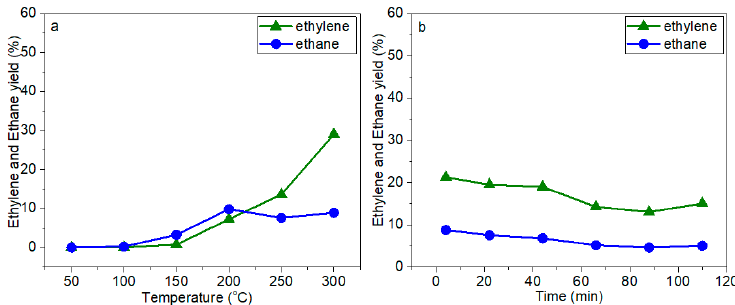
Figure 12. Catalytic HDCl of TCE on ZrO 2 supported mixed-shape (m) Pd NPs: ( a ) ethylene and ethane yield vs. temperature; and ( b ) ethylene and ethane yield vs. time at 200 °C.